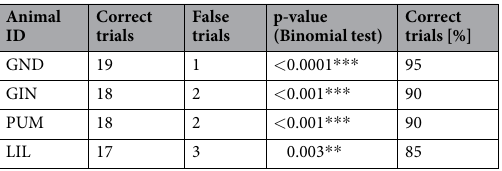
Table 2. Discrimination of water vs. conspecific urine odour across the last 20 trials in TS2.